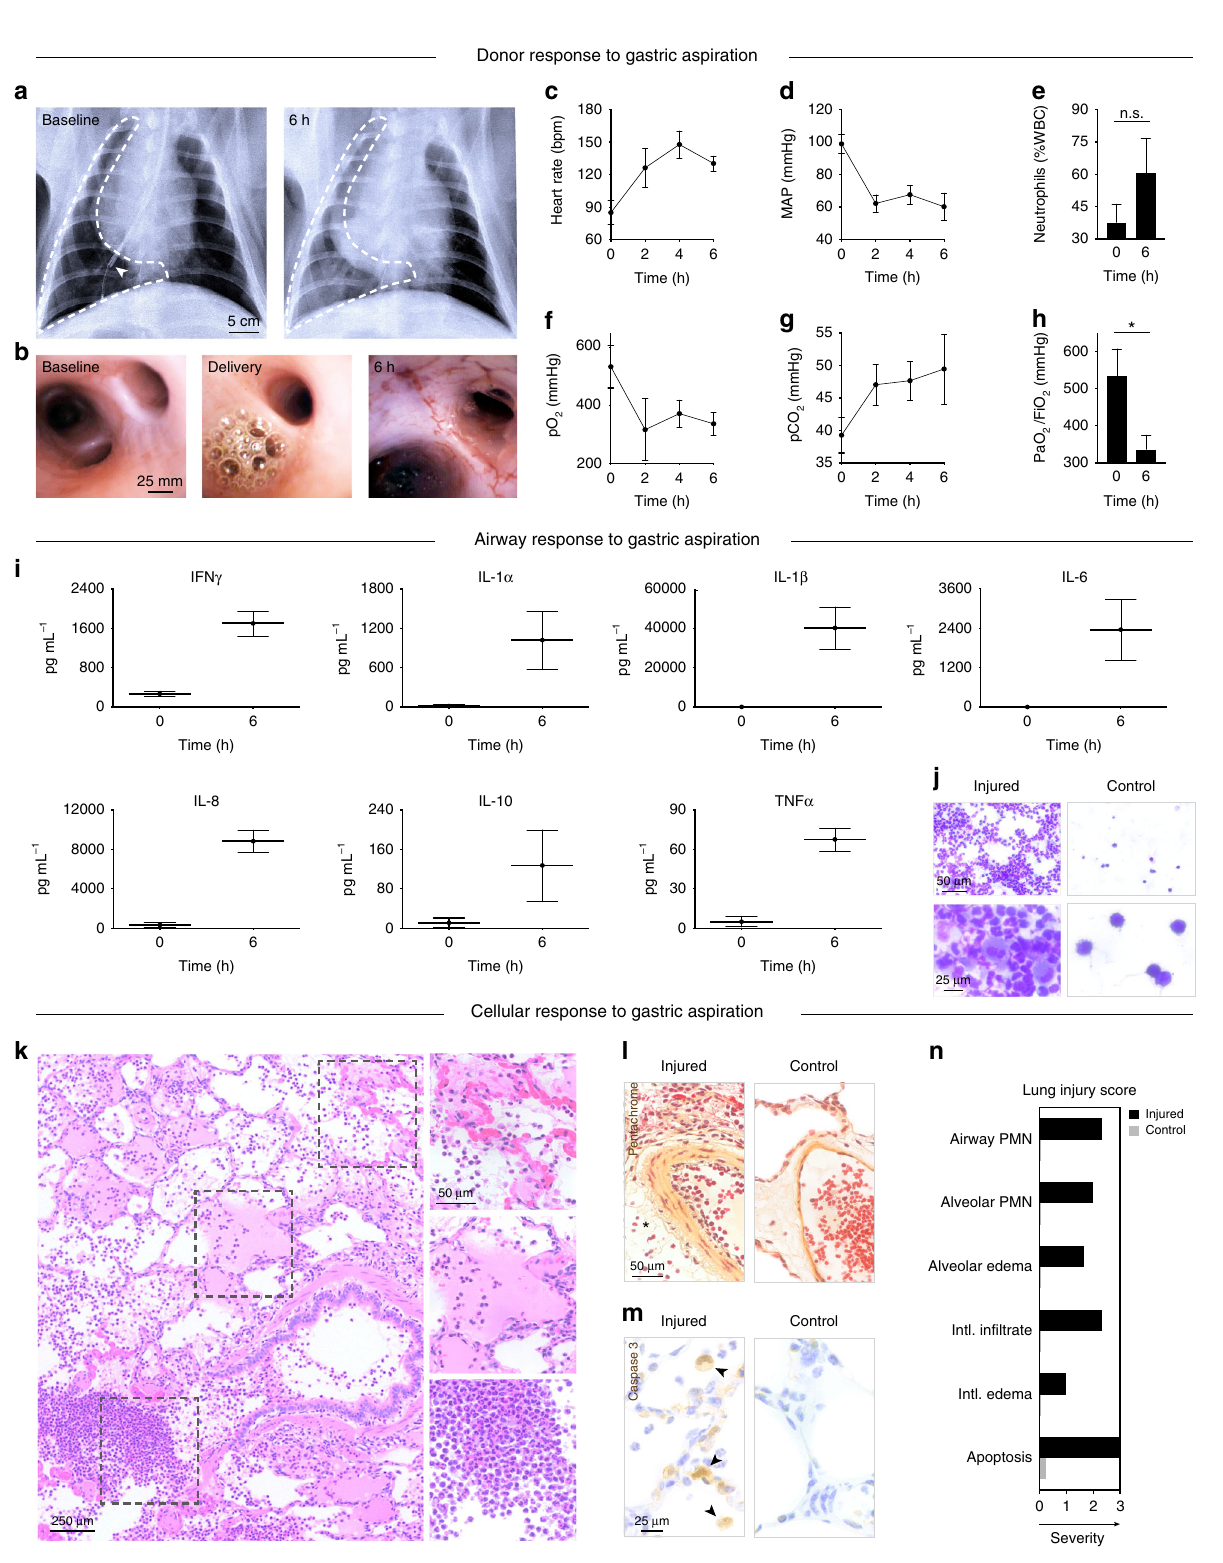
trended downward between 12 and 36 h of cross-circulation (Fig. 3g). Correlation between injury/in fl ammation and exosome concentration has been previously reported in other pathologic conditions 28,29 , and these results suggest that the concentration of exosomes in BAL fl uid may serve as a diagnostic marker of extracorporeal lung injury and recovery. Exosomes in BAL fl